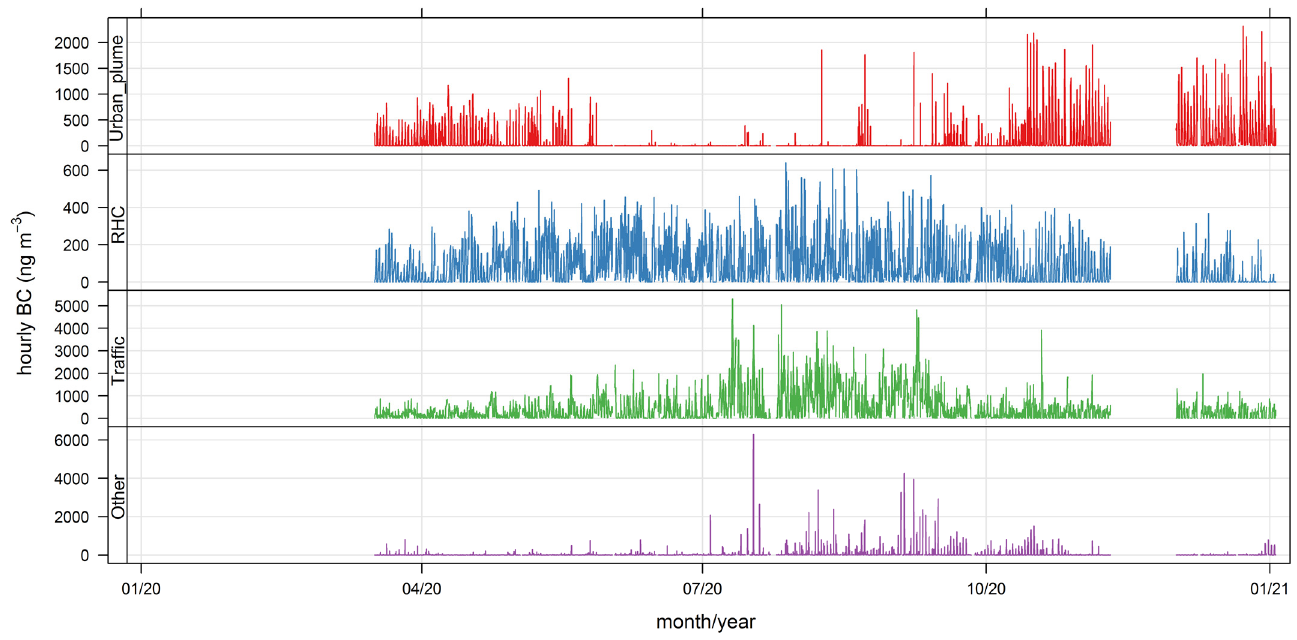
Figure A8. Time series plot of hourly BC ff source contributions, 2020 campaign.